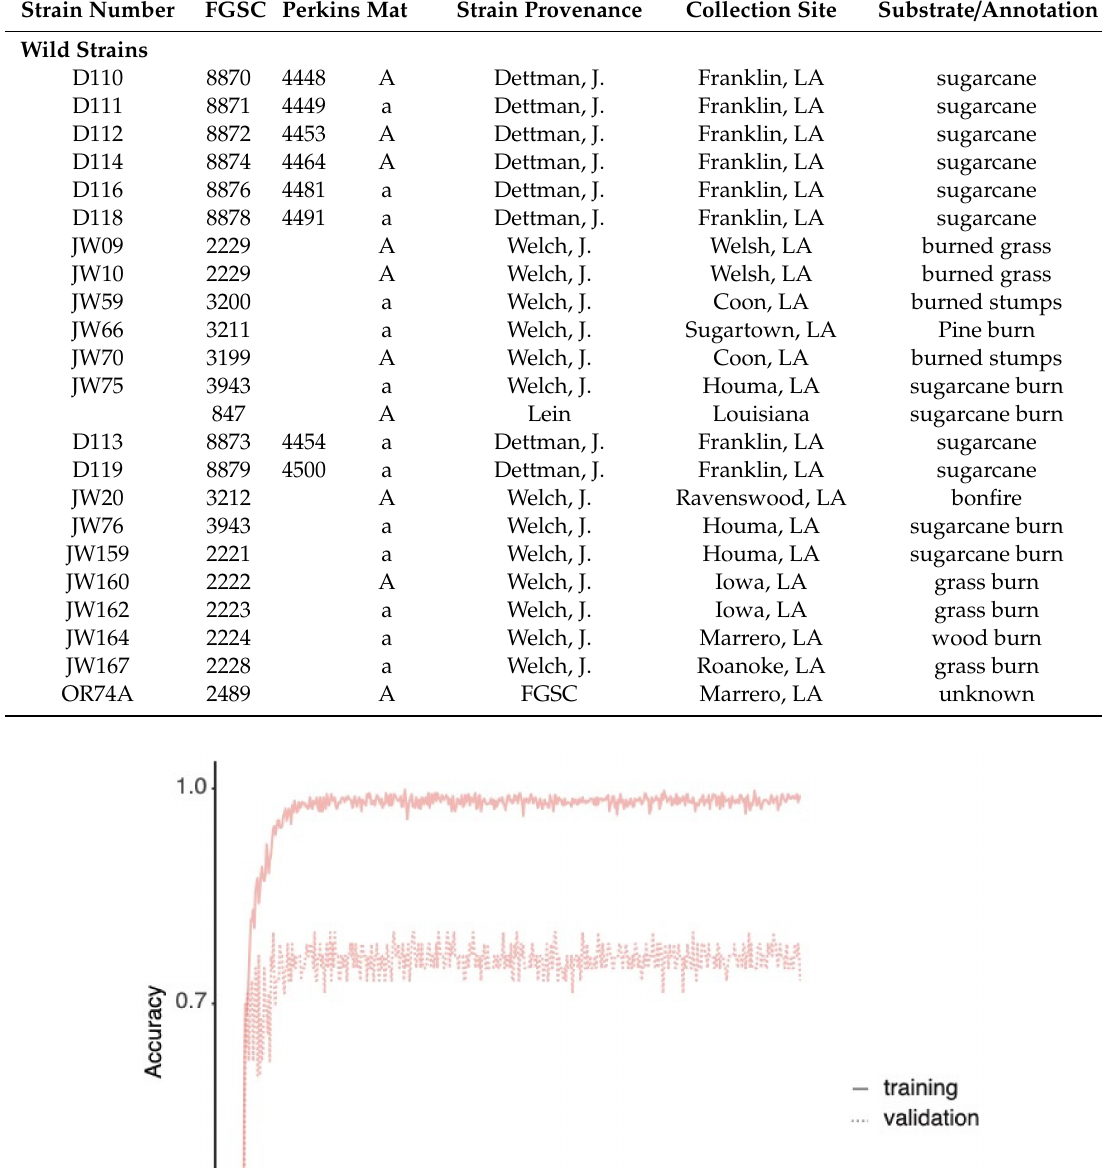
Table A1. Population of wild Louisiana isolates of N. crassa . Strains used in this study were obtained from the FGSC. Mating type (Mat) of each strain is denoted by A or a.